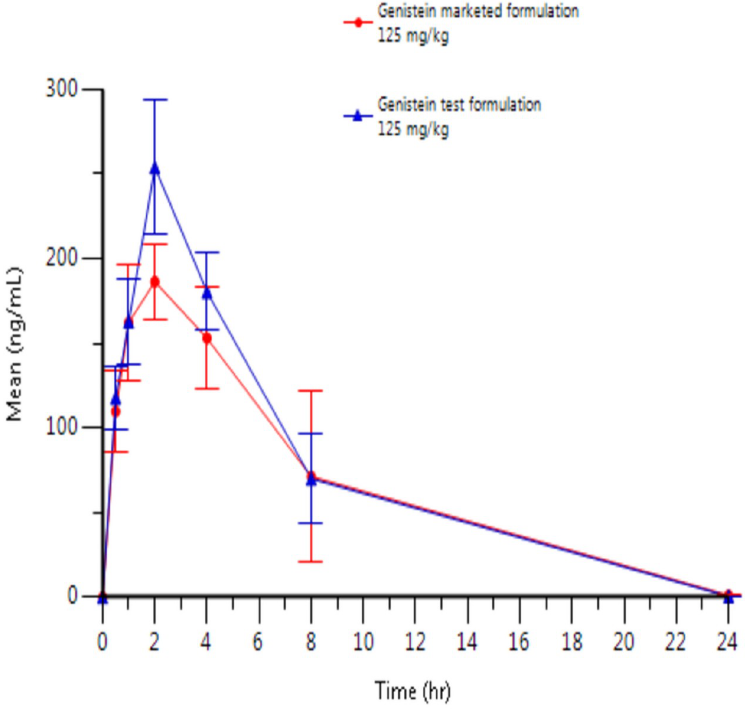
Fig 5. Arithmetic mean ( ± SD) plasma concentration of genistein after oral administration of genistein (125 mg/ kg) as marketed formulation or test formulation in male Wistar rats.